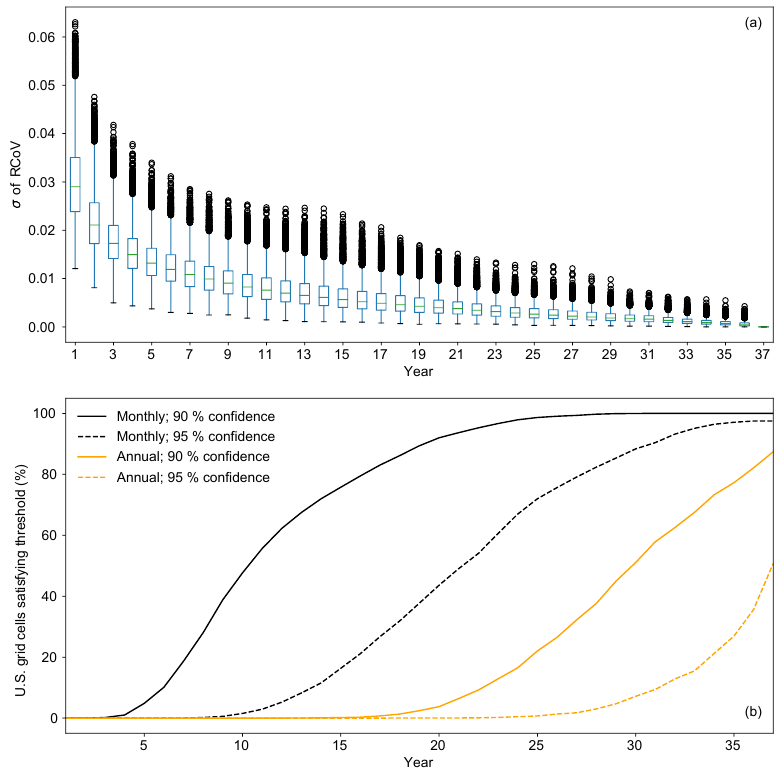
Figure 9. (a) Box plots of σ ’s of wind-speed RCoVs, where the RCoVs are calculated using monthly mean MERRA-2 data of 1 to 37 years. For each year, each box summarizes the σ from each MERRA-2 grid cell in the CONUS; (b) the time series of the cumulative fraction of grid cells in the CONUS that satisfies the threshold: when the pair of the χ 2 -derived σ ’s from the grid cell, calculated using the particular amount of data, become smaller than the 37-year σ . The solid black, dash black, solid orange, and dash orange lines, respectively, indicate the minimum length of data: when the wind-speed RCoV using monthly mean data yields a 10% deviation at maximum from the 37-year value at a 90% confidence level, when the wind-speed RCoV using monthly mean data yields a 5% deviation at maximum from the 37-year value at a 95% confidence level, when the wind-speed RCoV using yearly mean data yields a 10% deviation at maximum from the 37-year value at a 90% confidence level, and when the wind-speed RCoV using yearly mean data yields a 5% deviation at maximum from the 37-year value at a 95% confidence